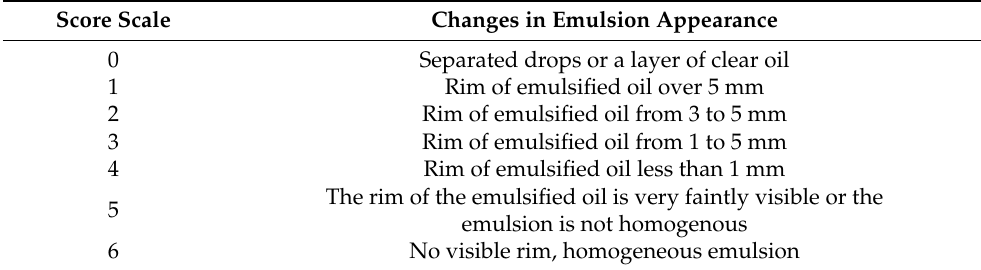
Table 3. Point classification of emulsions. Score